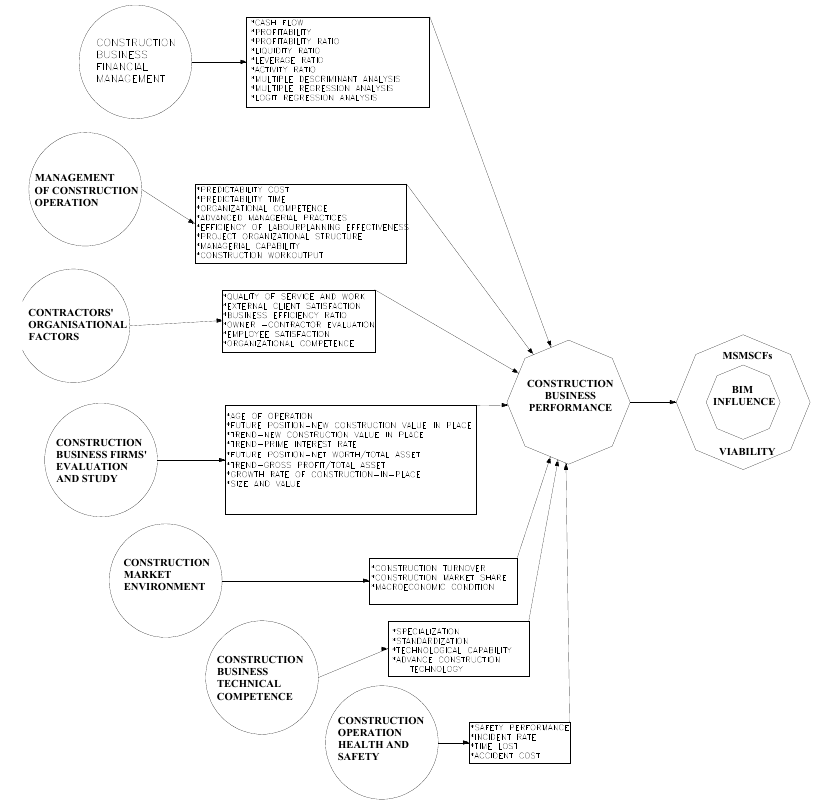
Figure 1. A conceptual model for the study.